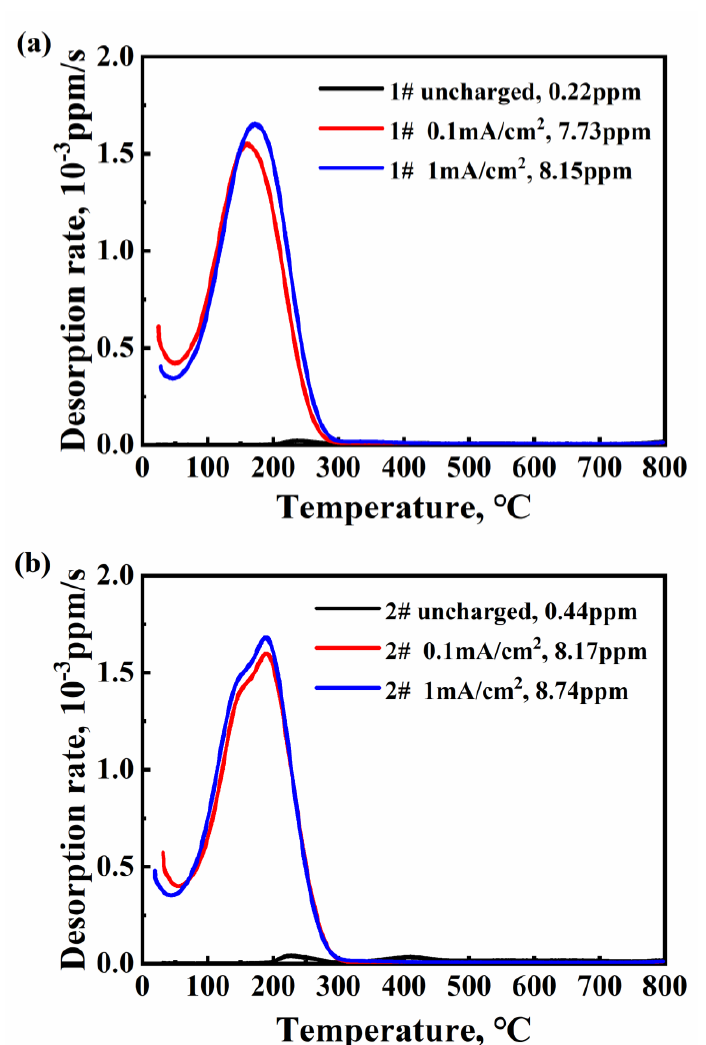
Figure 5. The effect of Mo content on the TDS spectrum of 1400 MPa-grade high-strength bolt steel. The heat rate was 100 K h −1 . ( a ) TDS spectra for 1# steel with different hydrogen-charging-current densities, ( b ) TDS spectra for 2# steel with different hydrogen-charging-current densities.